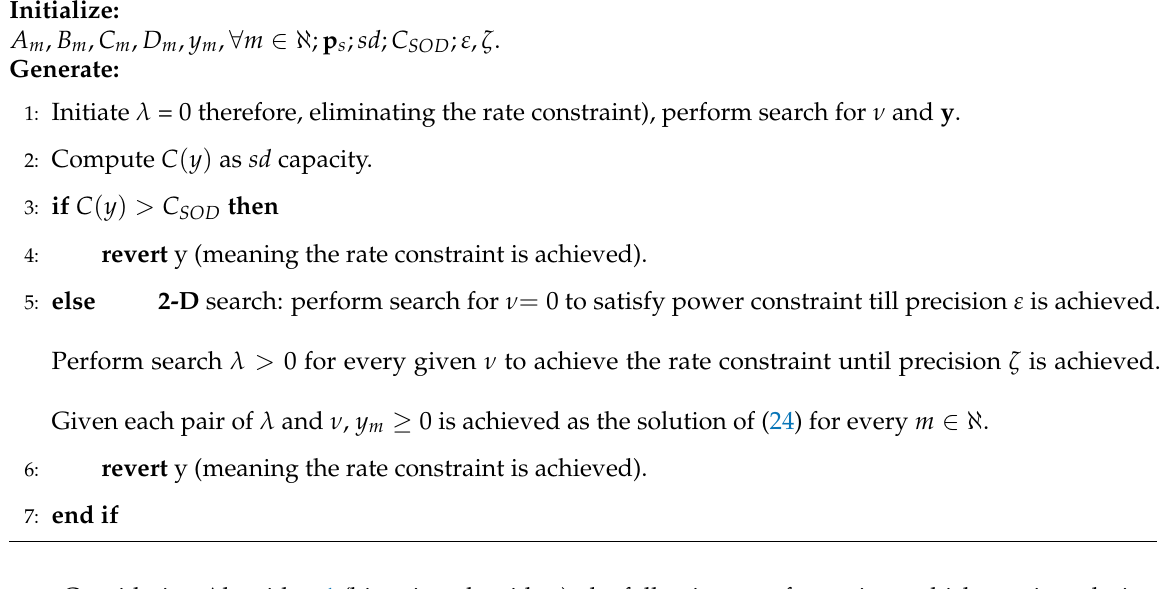
Algorithm 1 Algorithm to solve problem (15) by solving the KKT conditions of (16), using 2-D search approach for µ , ν , and λ